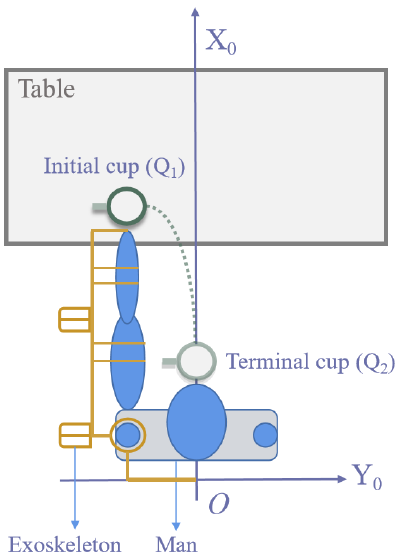
Figure 14. ADL (drinking)